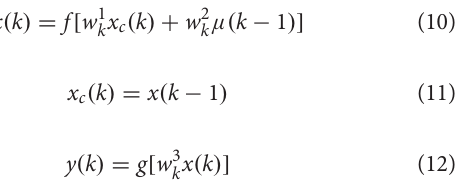
limited computing ability, for online training or prediction, the simple-structured ENN is an appropriate choice in this scenario.